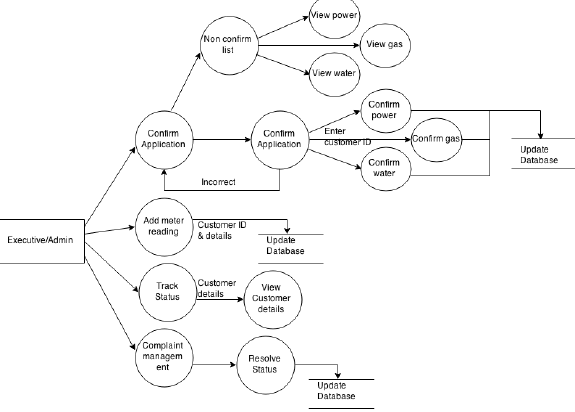
Figure 18. Detailed view of DFD for Executive in ISAU